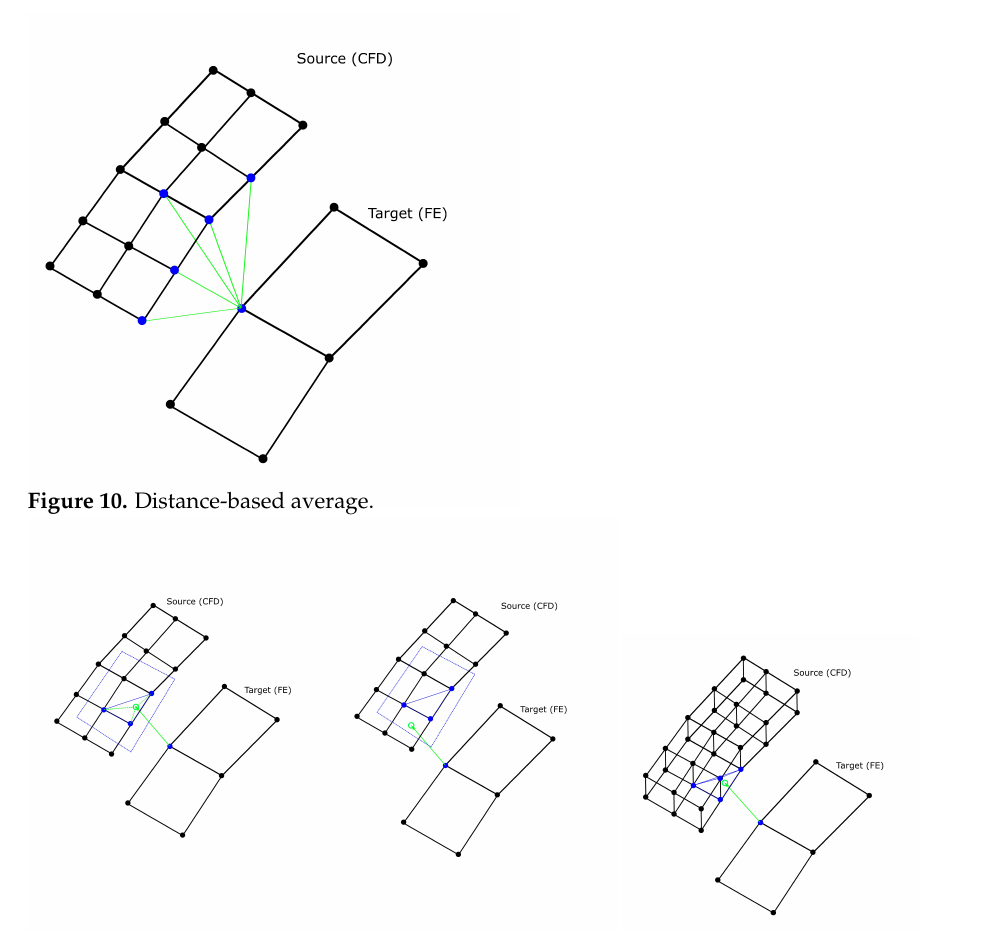
Figure 11. Triangulation: surface option ( left ); surface option, projection point outside ( middle ); volumetric option ( right